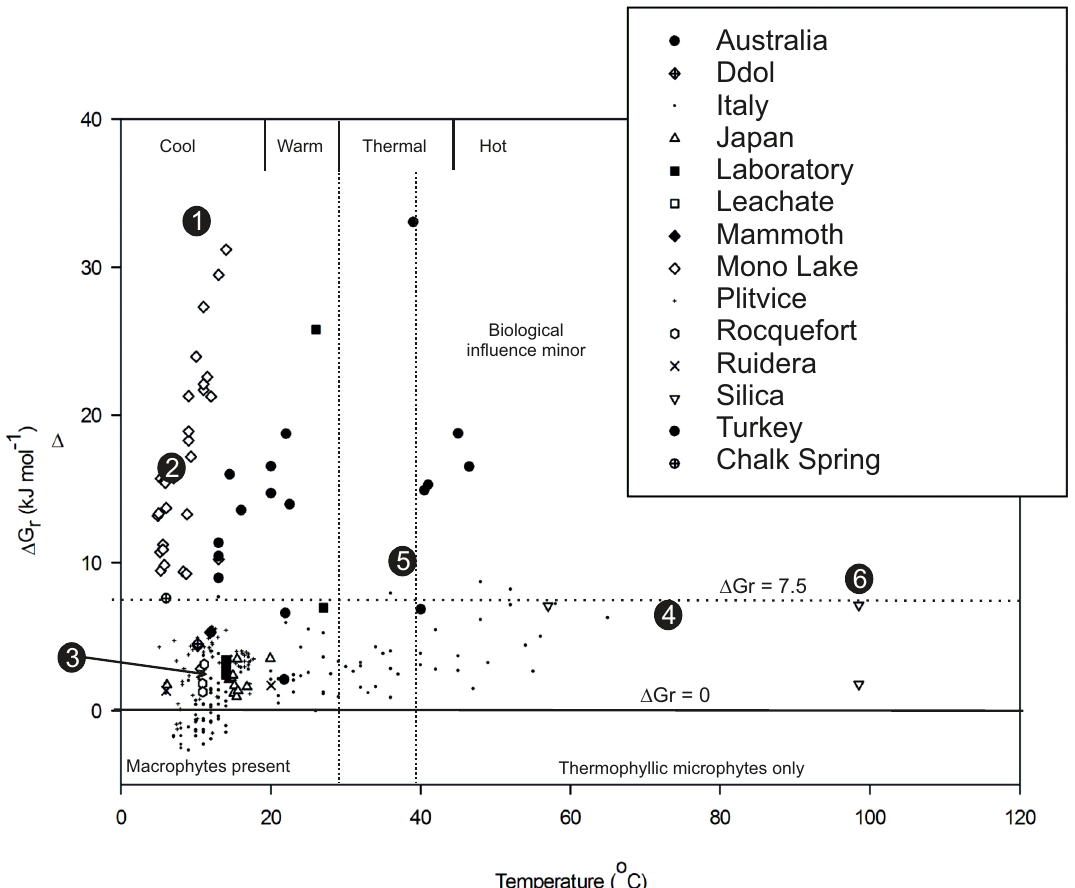
Figure 3. Summary of travertine and tufa spring water chemistries on thermodynamic grounds (see Sect. 3). 1: ,Brook Bottom (Sect. 3.3), 2: Mono Lake (Sect. 3.3), 3: Plitvice (Sect. 3.4), 4: Angel Terrace (Sect. 3.2), 5: Terme San Giovanni (Sect. 3.1), 6: Chemerkeu Spring (Sect.